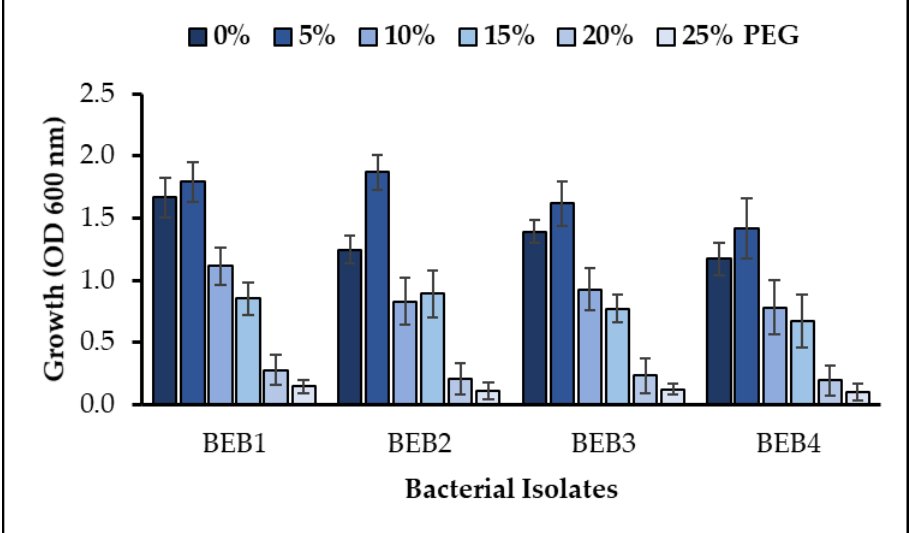
Figure 2. Relative growth of wastewater isolated bacterial strains in different concentrations of polyethylene glycol (PEG 6000) in culture medium (values are the mean of three replicates and the bar represents the standard error); LSD value ≤ 0.05.